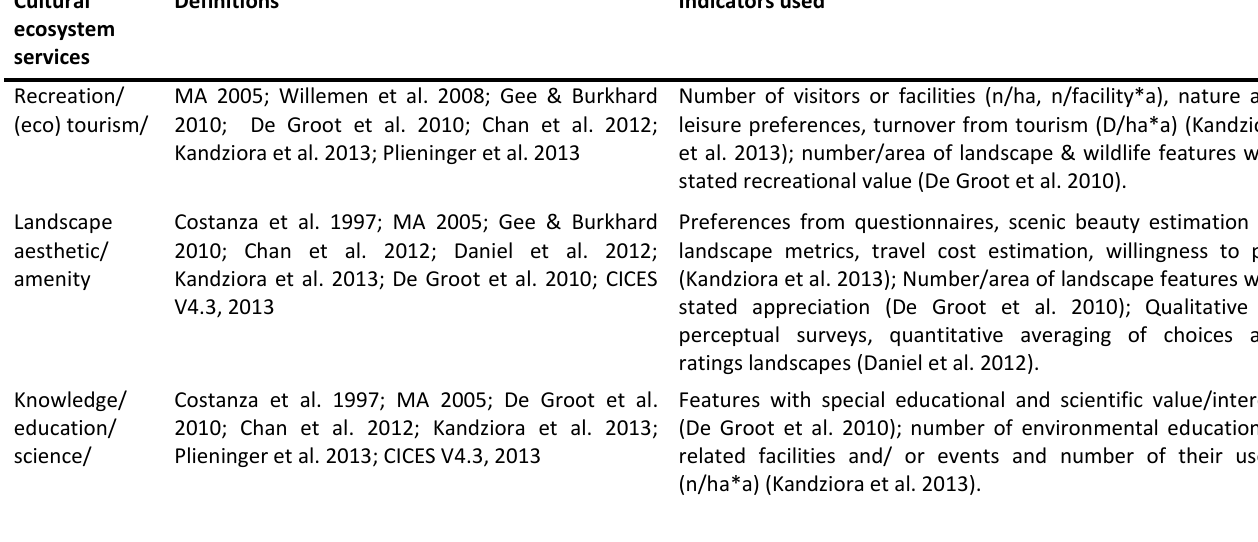
Table 1: A literature overview for the definitions of cultural ecosystem services